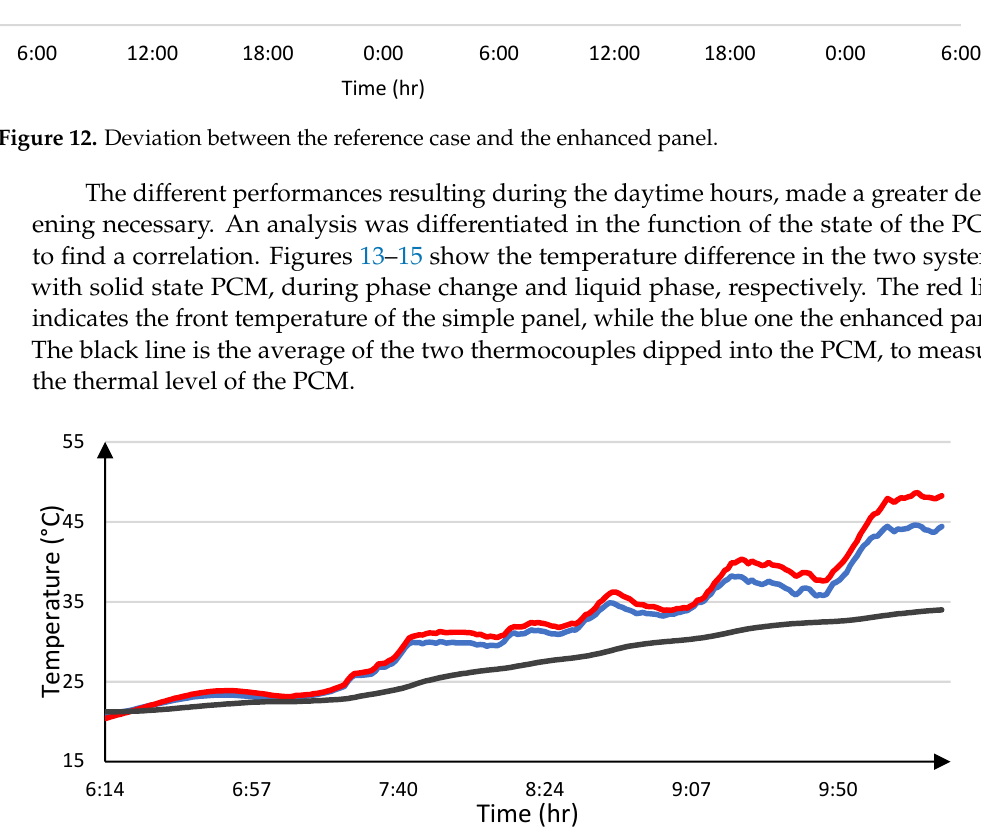
Figure 13. Temperatures during solid state PCM. The red line indicates the front temperature of the simple panel, the blue one the enhanced panel. The black line is the average of the two thermocouples dipped into the PCM.